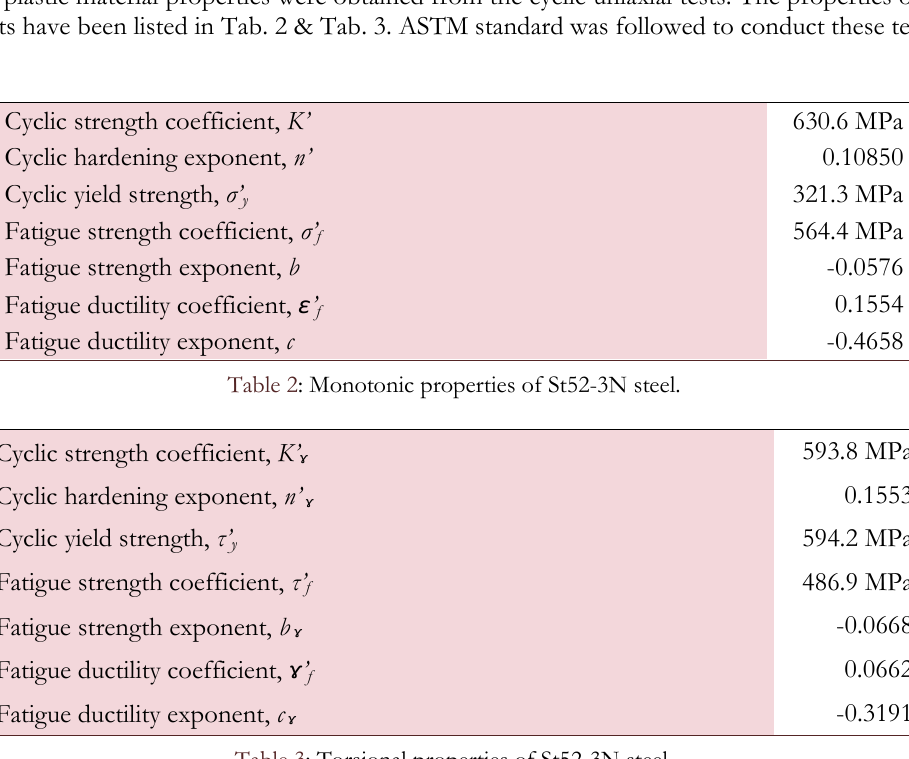
Table 3: Torsional properties of St52-3N